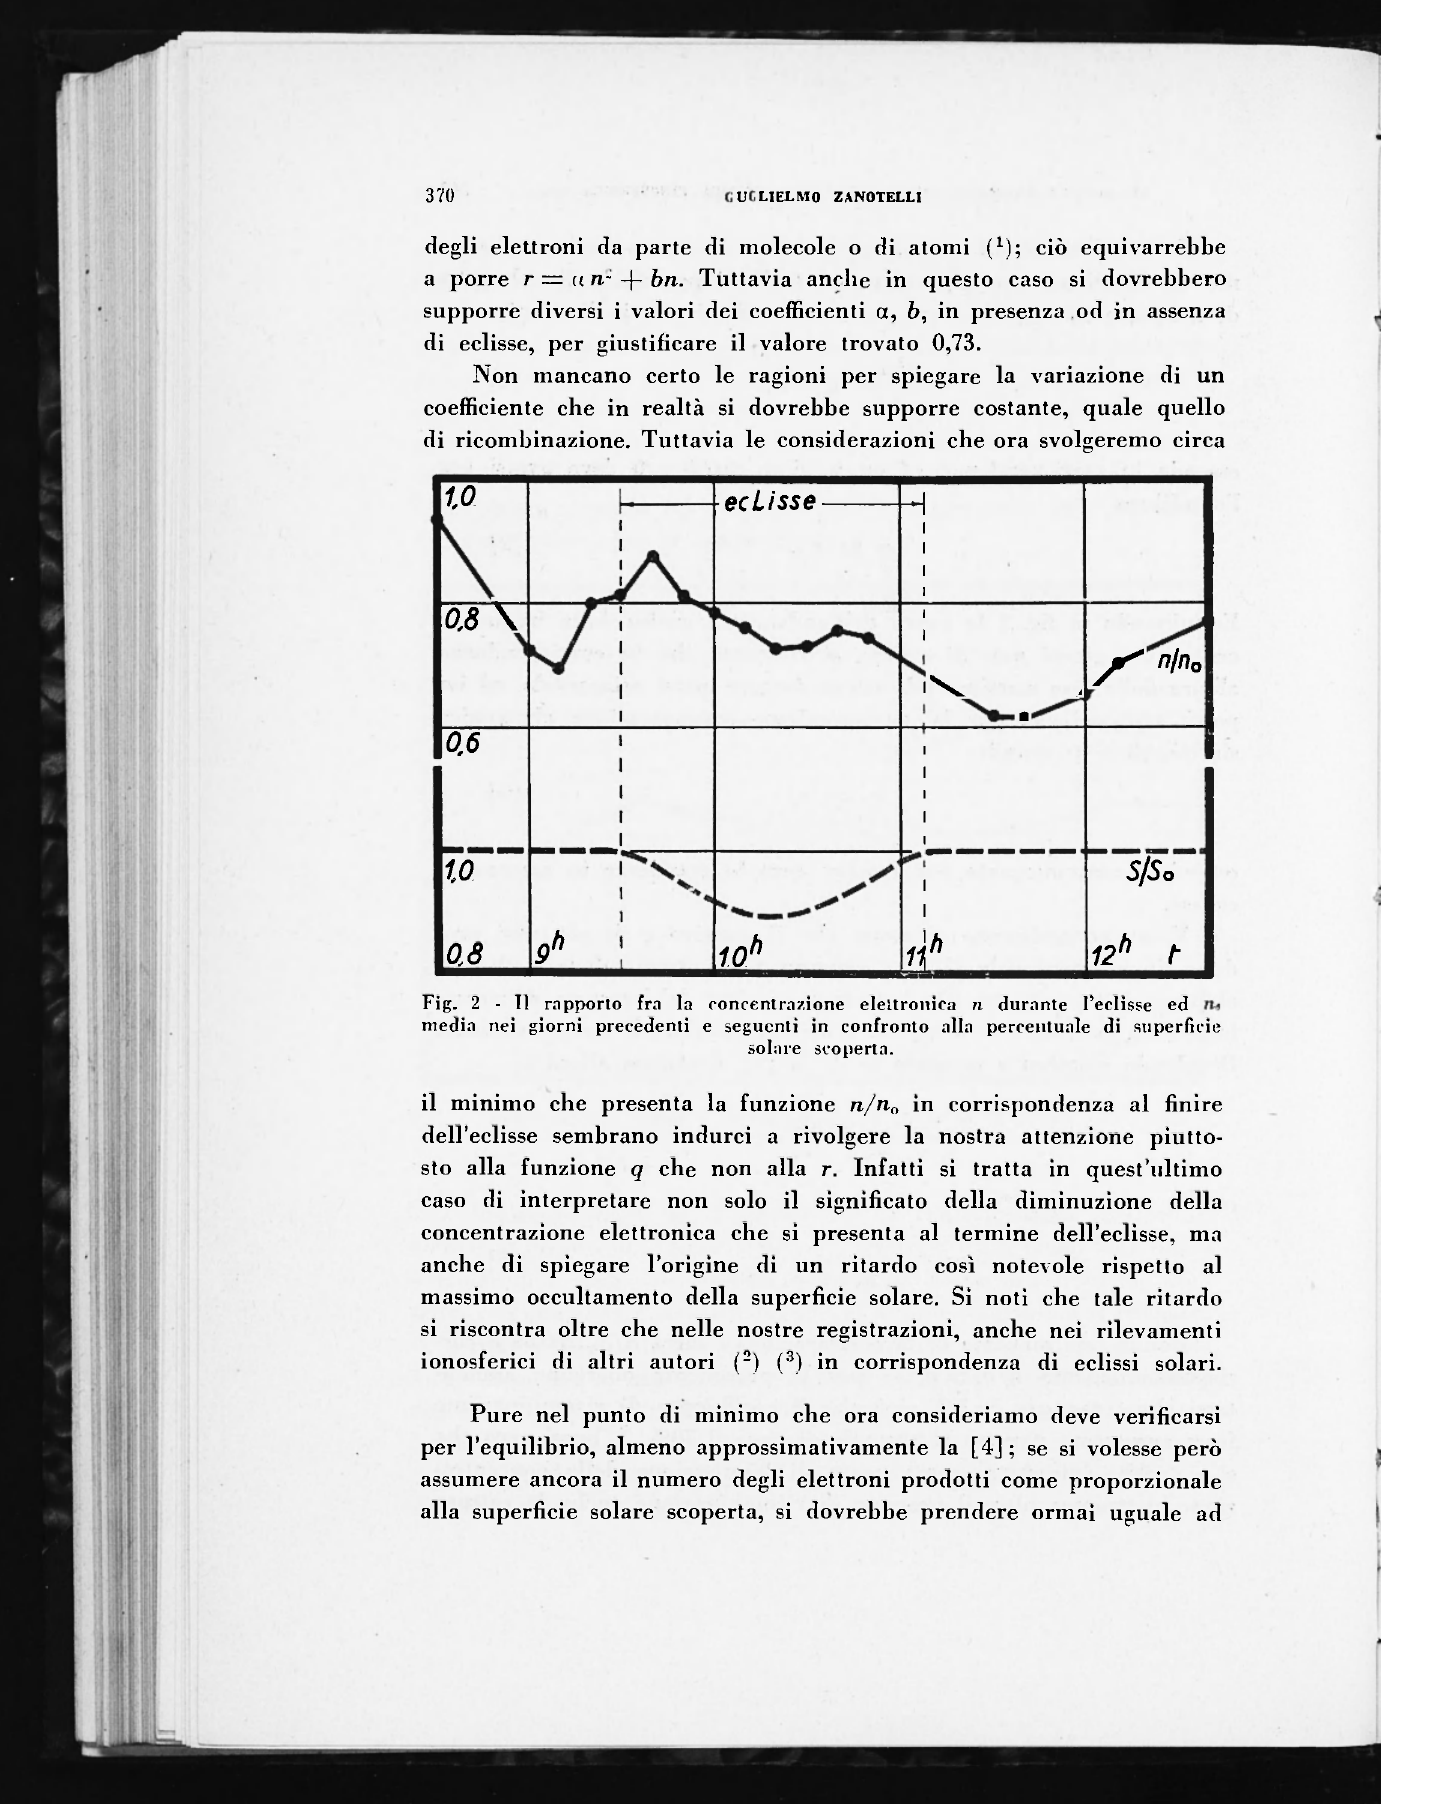
Fig. 2 • TI rapporto fra la concentrazione elettronica n durante l'eclisse ed media nei giorni precedenti e seguenti in confronto alla percentuale di superficie solare